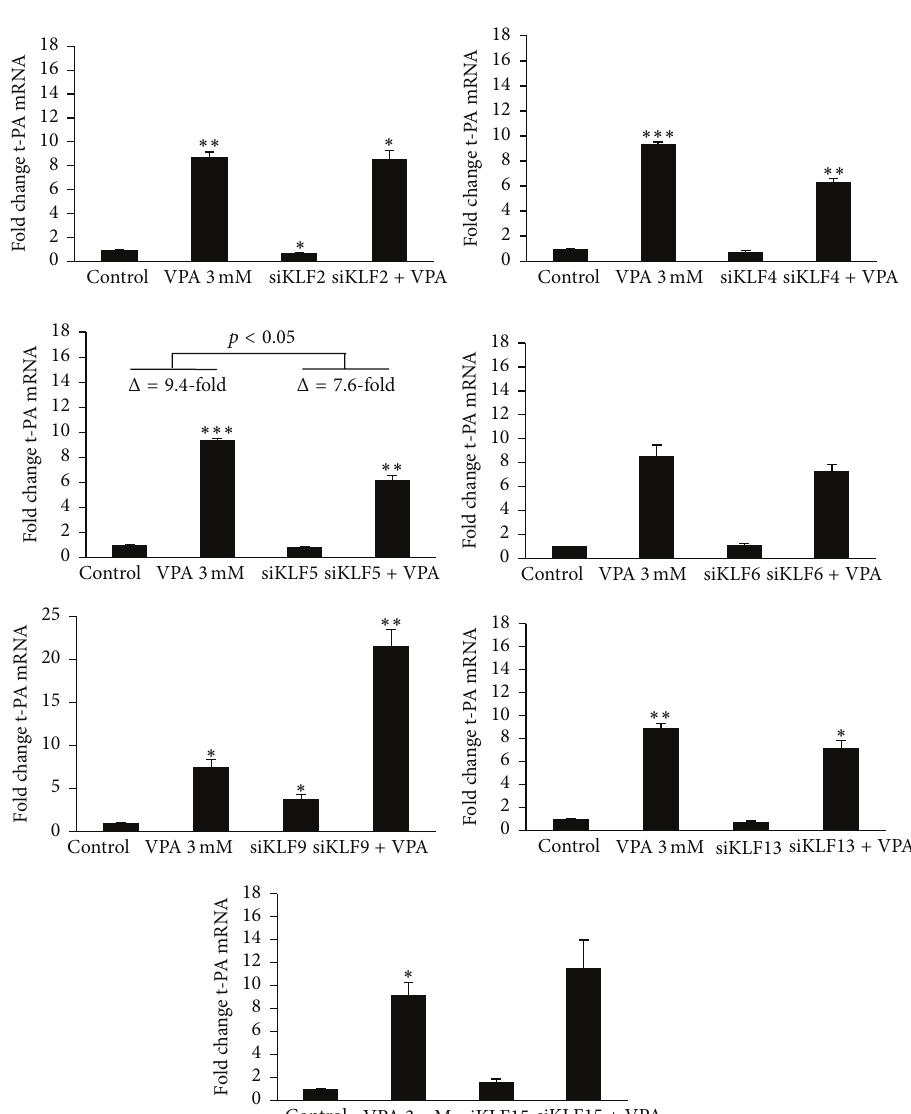
Figure 5: t-PA mRNA expression after siRNA mediated knock-down of KLF factors. HUVECs were treated with siRNA targeting KLF2, KLF4, KLF5, KLF6, KLF9, KLF13, or KLF15 for 72 h and then stimulated with 3 mM VPA for 24 h. Statistical comparisons are made relative to untreated control cells. The mark indicates the statistical comparison of the VPA-induction in nontransfected cells versus the VPA-induction in transfected cells ( Δ = change in t-PA mRNA expression after VPA stimulation). ∗ 𝑝 < 0.05 , ∗∗ 𝑝 < 0.01 , and ∗∗∗ 𝑝 < 0.001 . The results are presented as mean values ± SEM of three (KLF6), four (KLF2, KLF4, KLF5, KLF13, and KLF15), or five (KLF9) independent experiments. The statistical evaluation was performed using paired Student’s 𝑡 -test together with Bonferroni correction for multiple analysis. Not shown in the illustrations are transfection controls with transfection reagent only (mock) and transfection with “All Star Negative” control siRNA (ASN) that were included in each experiment. These negative controls showed no significant effect on either t-PA or target